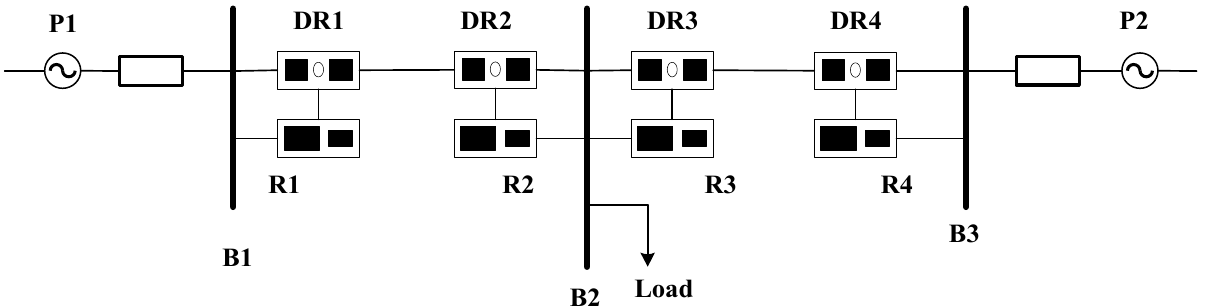
Figure 7. The topology of a three-bus two-line transmission system.